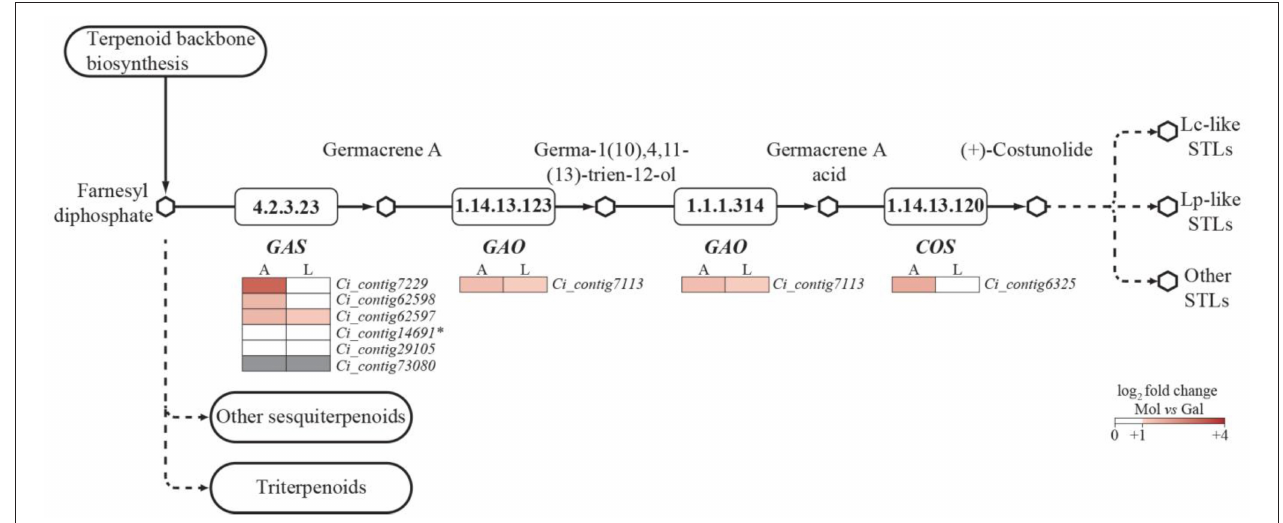
FIGURE 5 | Unigenes predicted to be involved in the Costunolide biosynthesis (a key precursor of Sesquiterpene lactones, STLs), in the Sesquiterpenoid and triterpenoid biosynthetic pathway. Expression patterns of GAS ( Germacrene A synthase ), GAO ( Germacrene A oxidase ), and COS ( Costunolide synthase ) unigenes were monitored in Mol and Gal in both Apulia (A) and Lazio (L). Differential expression patterns (FDR ≤ 0.05; |log 2 fold change| ≥ 1) between the two landraces are represented by color gradation. Gray boxes highlight unigenes not expressed in stems (average RPKM 0–0.1). The asterisk marks a partial